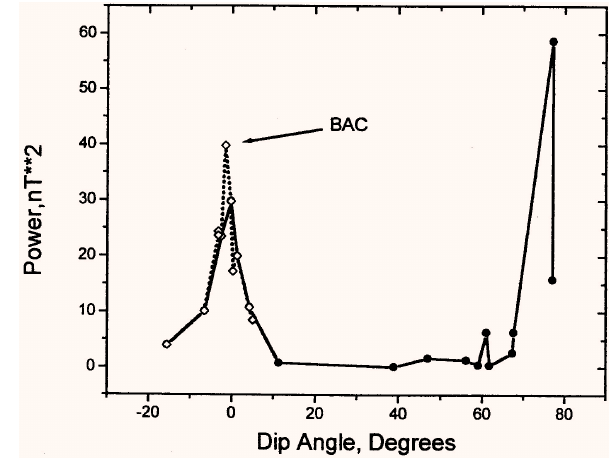
Fig. 5. Variation of Polarized Spectral Power (PSP) as a function of dip latitude – solid curve (Trivedi et al., 1997b). Broken curve shows the variation in PSP within the equatorial region when data from stations like BAC, contaminated by the anomalous induction effects, are